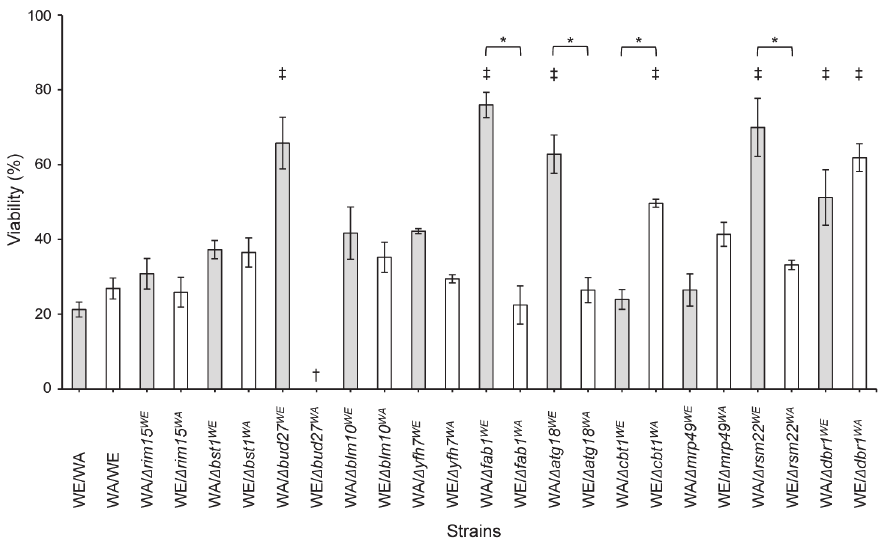
Fig 3. Hybrid viability after DRS. The scale of viability (%) indicates the percentage of experimental values for the different strains. The values shown are the means of at least n = 3 independent samples ± SD. † Non- viable strain. * Significant differences at p (cid:3) 0.01 between hemizygous strains. ‡ Significant differences at p (cid:3) 0.01 between the hemizygous and reference